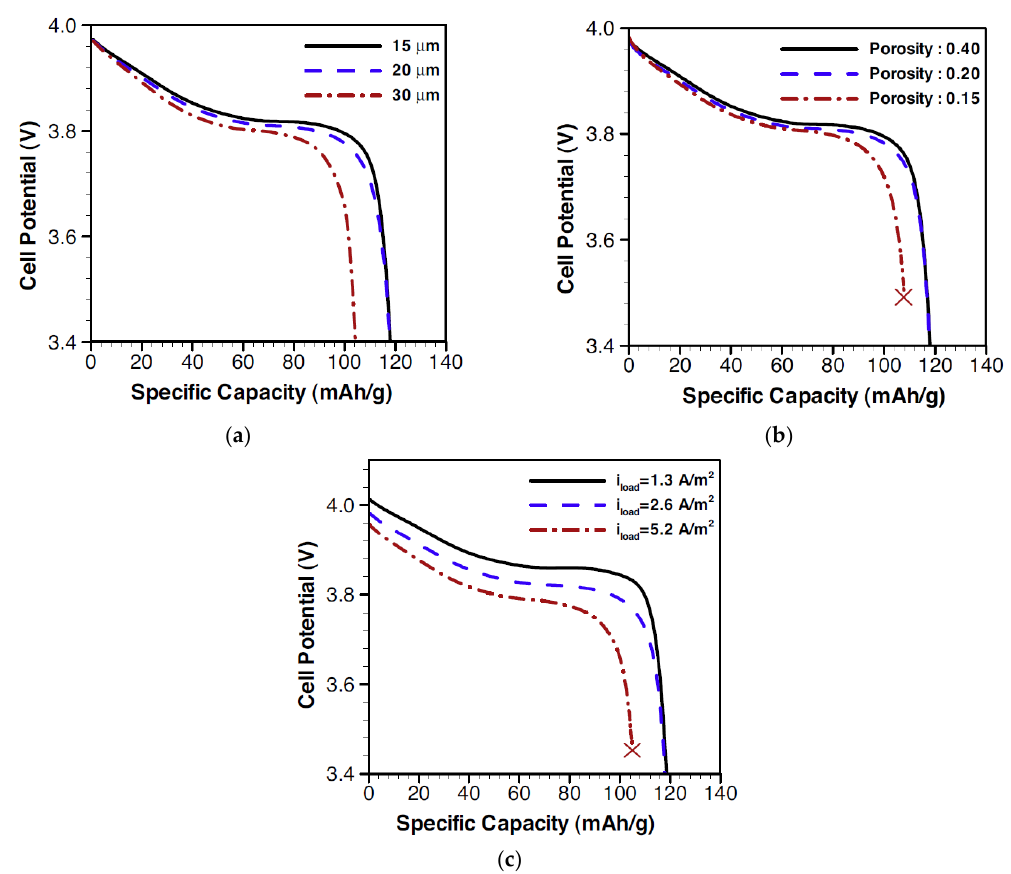
Figure 30. Electric performance of battery depending on ( a ) separator thickness; ( b ) separator porosity; and ( c ) load current. Adapted with copyright permission from Yoo et al. [39], with permission from Elsevier. Table 2. Transport and dissolution properties of ions. Adapted with copyright permission from Yoo et al. [44], with permission from Elsevier.